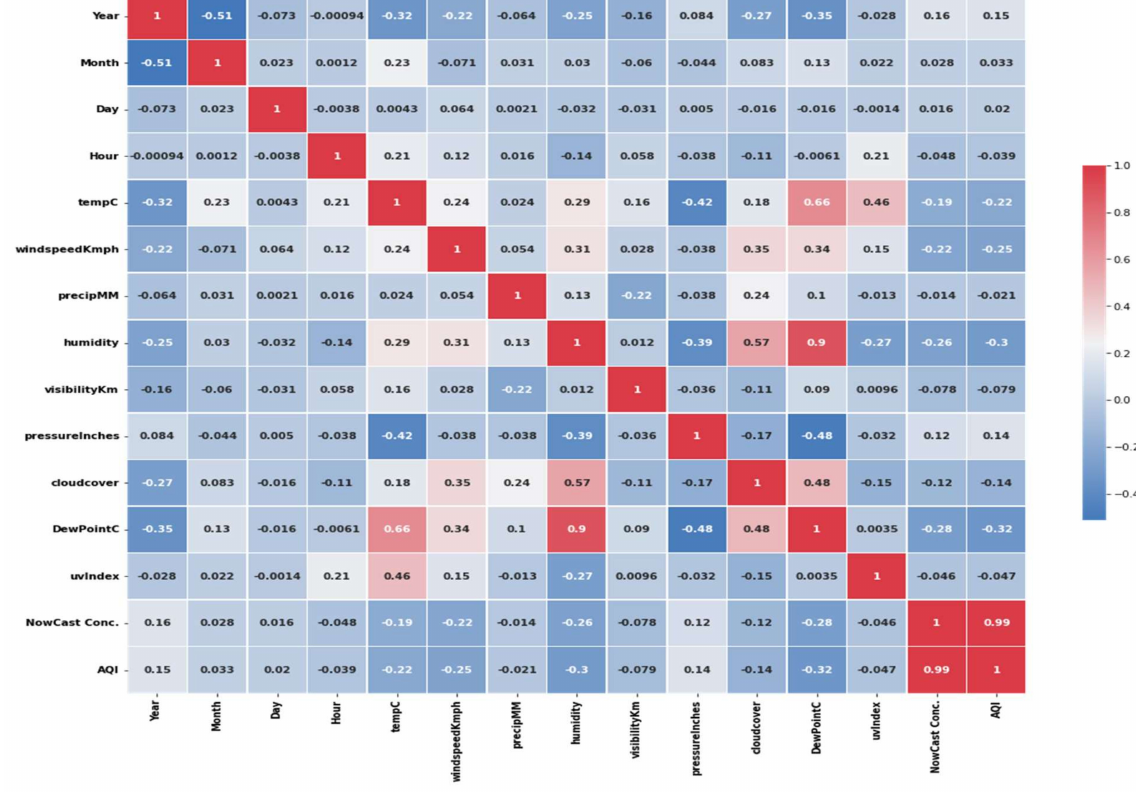
Figure 23. Correlation heat map for